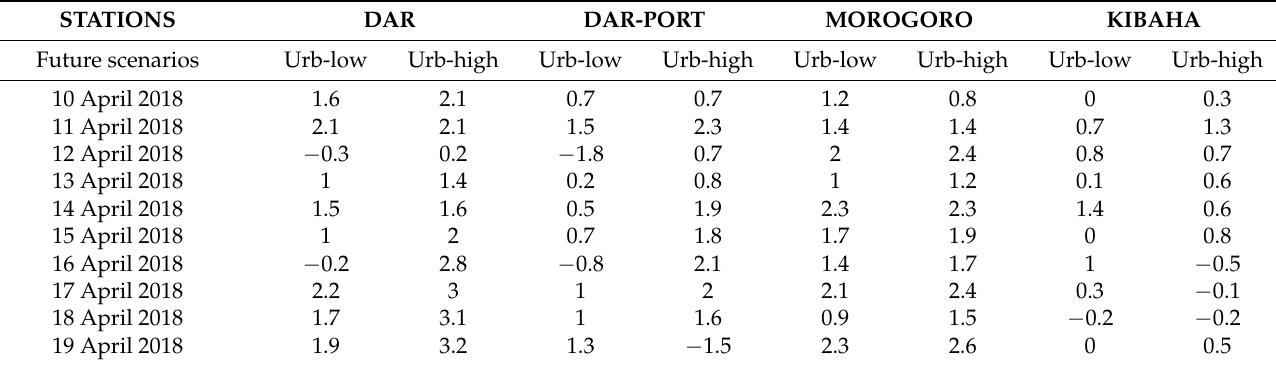
Table 7. Daily minimum temperature difference ( ◦ C) between future urbanization scenarios and current LULC at four sta- tions.